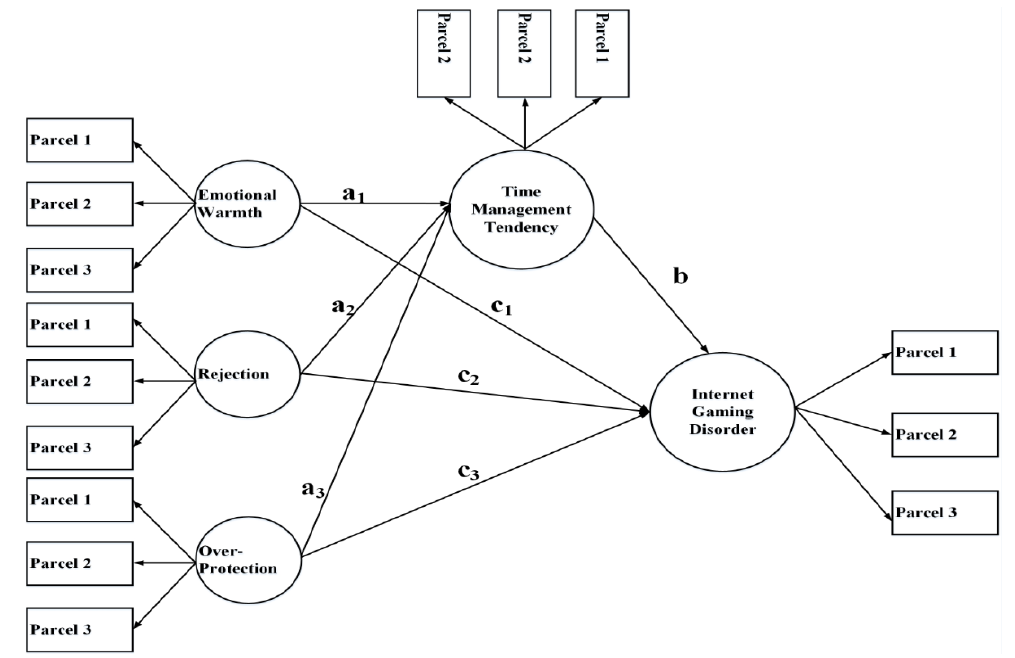
Figure 1. Conceptual model for mediation analysis.